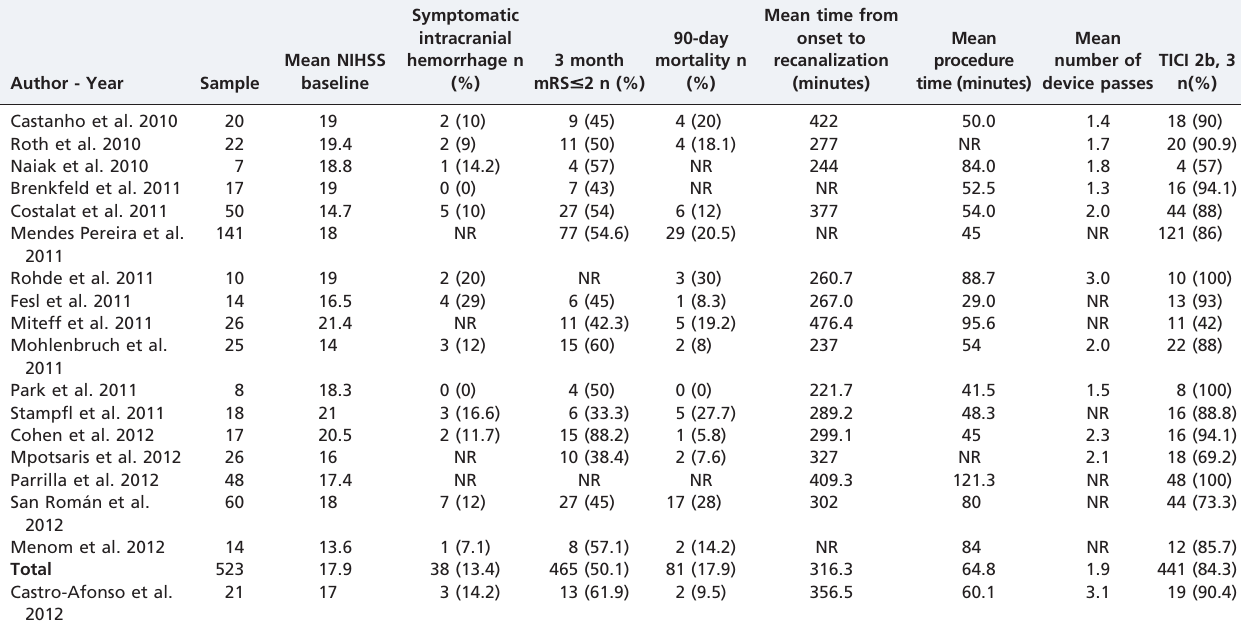
Table 2 - The main studies assessing the use of retrieval devices for treating acute ischemic stroke (searched in PubMed through May 1, 2012).